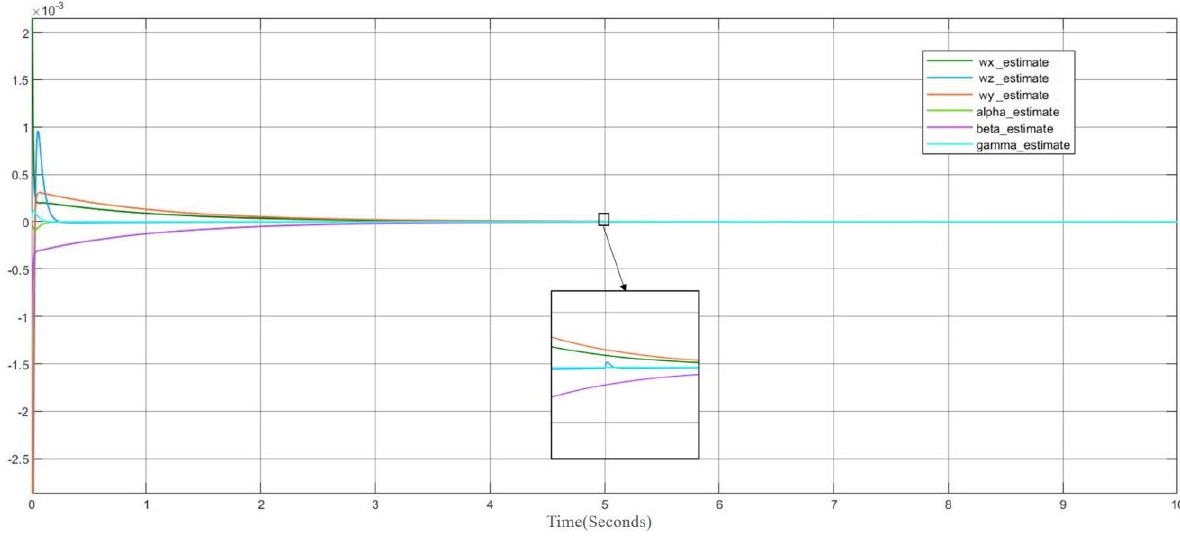
Figure 10. Input 2’s 40% PLOE fault detection simulation.